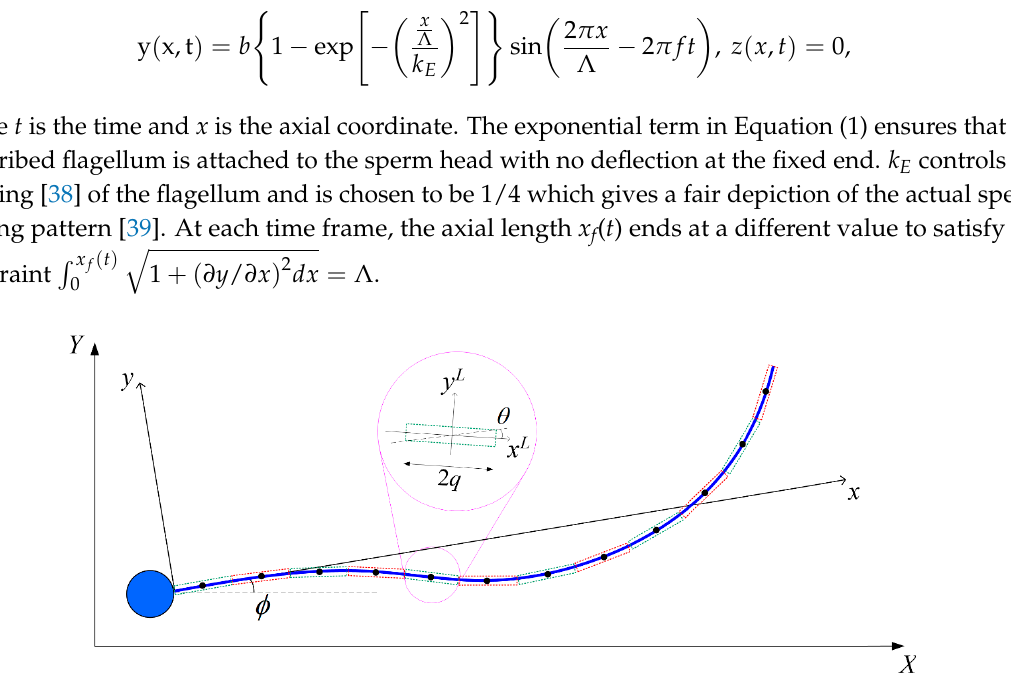
Figure 1. Flagellum comprising N discrete straight segments, each represented by a dotted rectangle. Inset: the local coordinate system x L and y L of a segment at an angle θ with respect to the general x -axis of the body-fixed frame x - y .